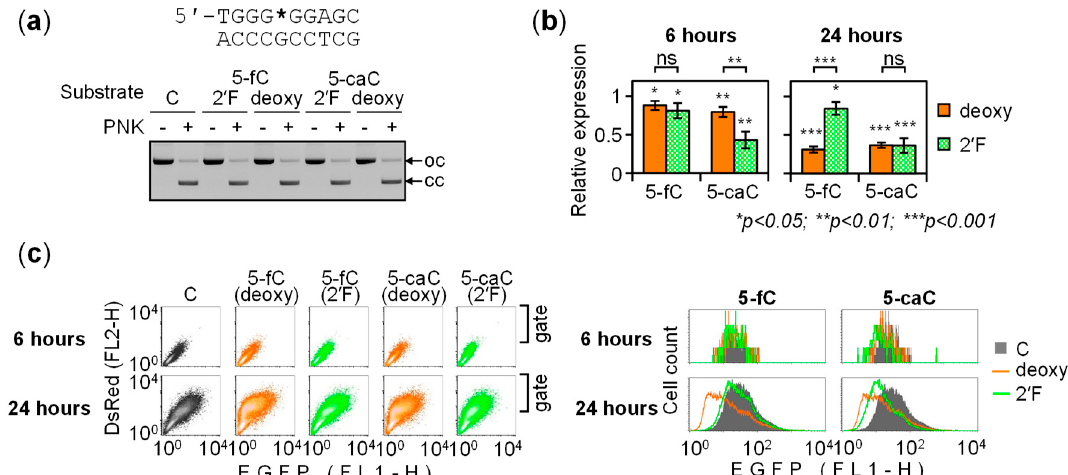
Figure 3. Effects of BER-resistant analogs of 5-fC and 5-caC in the purine-rich strand on the GC box activity. ( a ) Efficient incorporation of 5-fC and 5-caC deoxyribonuceotides (deoxy) and their 2 ′ -( R )-fluorinated analogs (2 ′ F) into the purine-rich strand of the GC box. Agarose gel electrophoresis of the fully ligated constructs and the respective “no PNK” controls. The open circular (oc) and covalently closed (cc) forms are indicated by arrows. ( b ) Quantification of the EGFP expression driven by GC box containing 5-fC and 5-caC with or without 2 ′ -fluorination, relative to C, 6 and 24 h post-transfection (mean ± SD, n = 4 independent experiments). ( c ) A representative flow cytometry experiment. Cells were gated based on the expression of the transfection marker DsRed, as shown on two-dimensional fluorescence scatter-plots (left panels), and the resulting EGFP signal distributions (right panels, samples overlaid) analyzed to determine the median EGFP fluorescence.